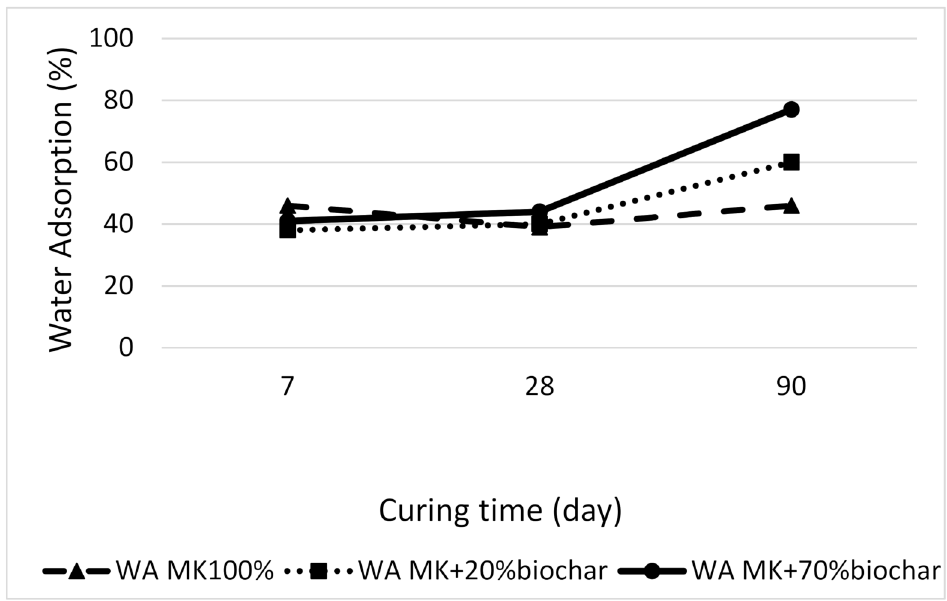
Figure 8. WA trend of MK + Biochar series at 7, 28, 90 days of